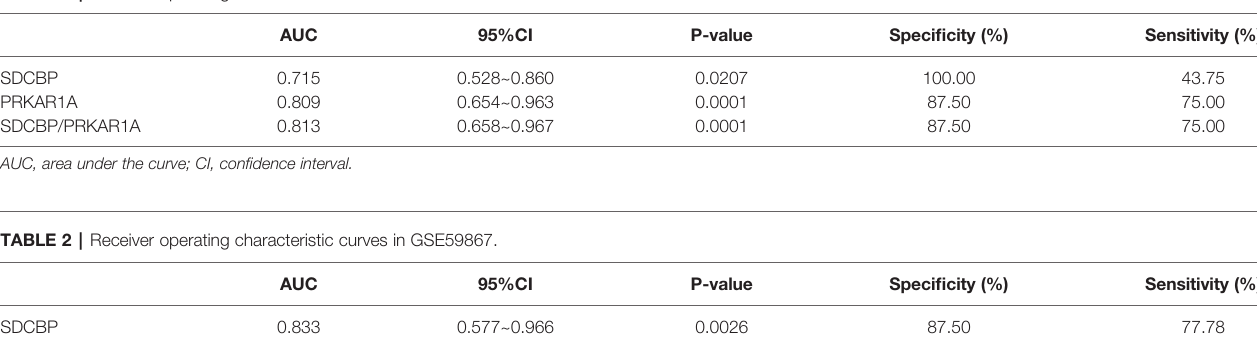
TABLE 1 | Receiver operating characteristic curves in GSE11947.